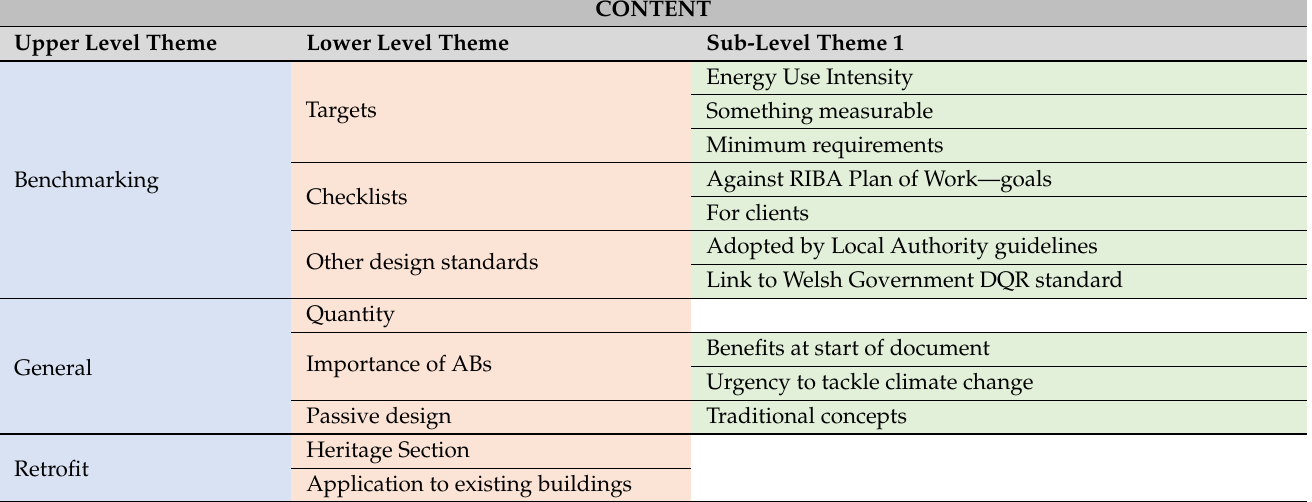
Table 4. Summary of combined FG data regarding the “Content” of the ABDG